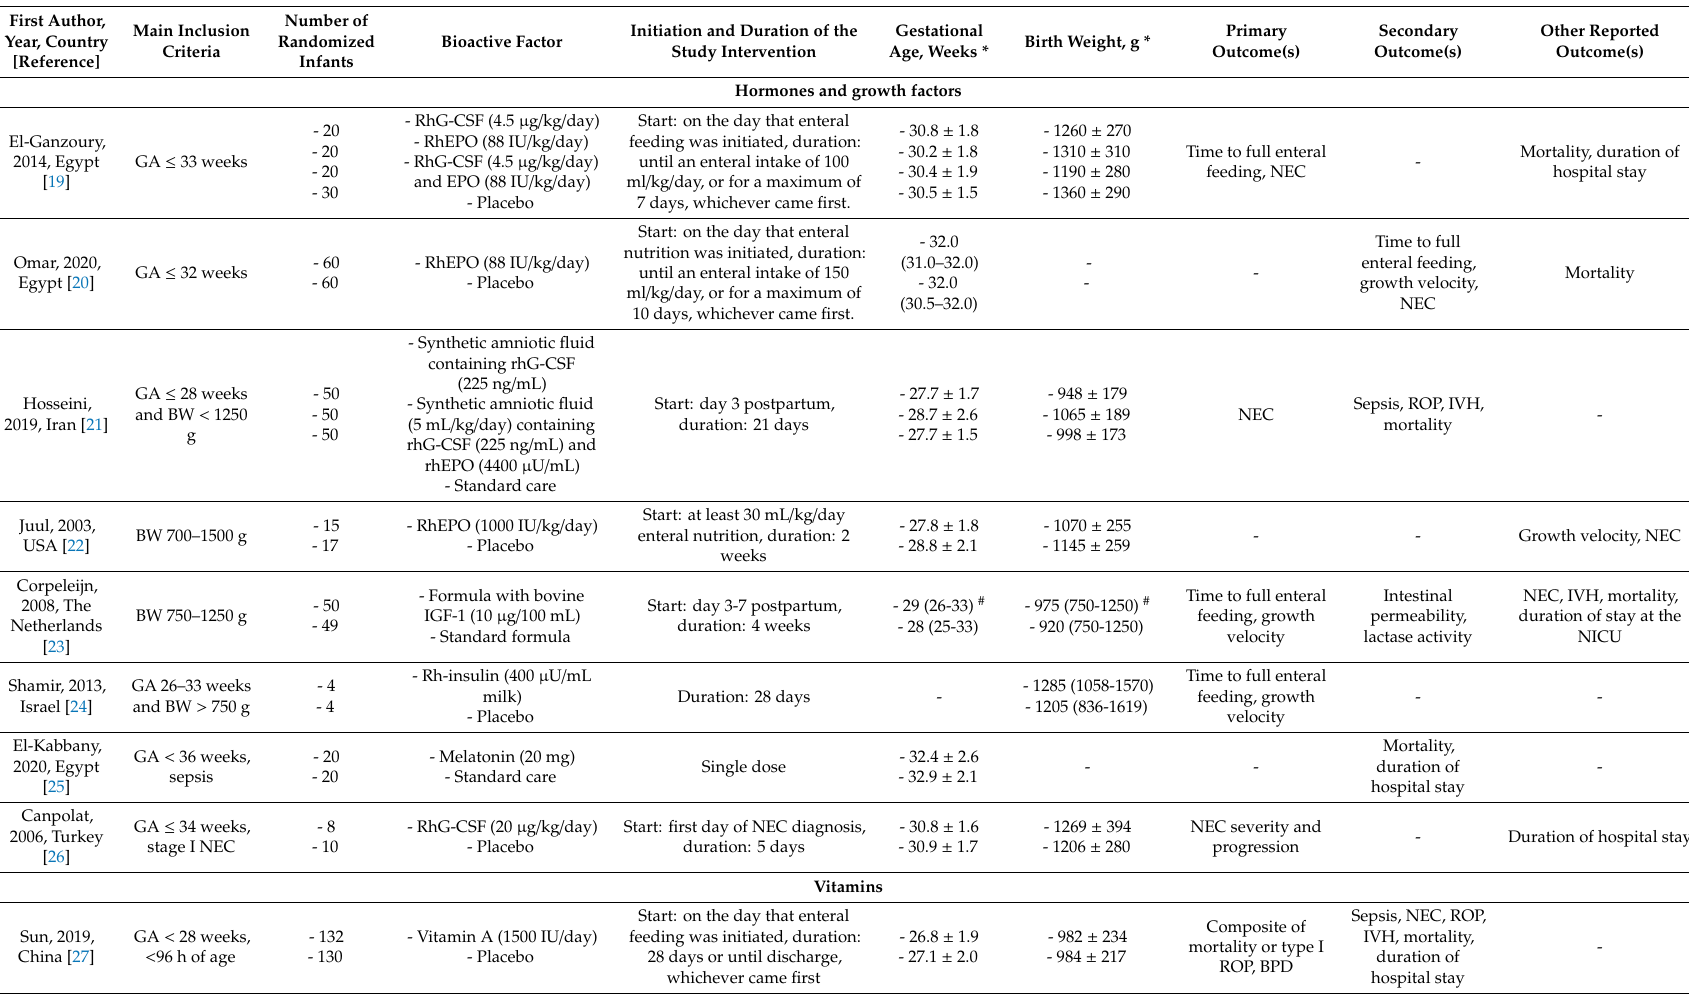
Table 1. Overview of the included